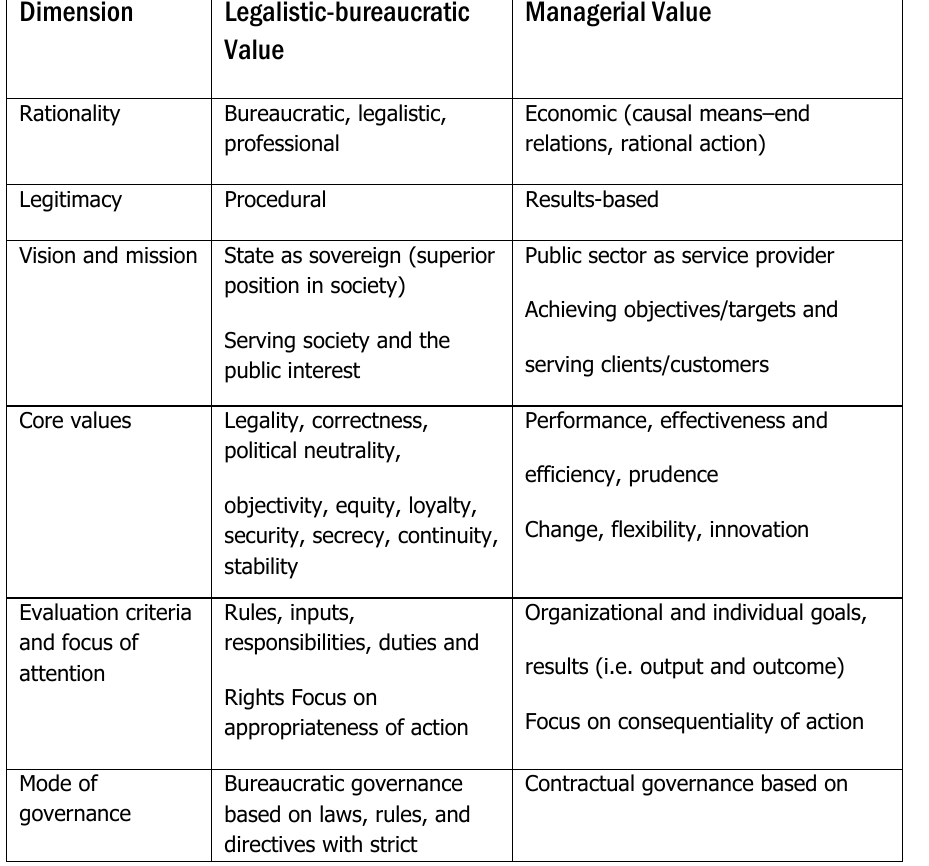
Table 1: Institutional Values in operation in African Public Sectors